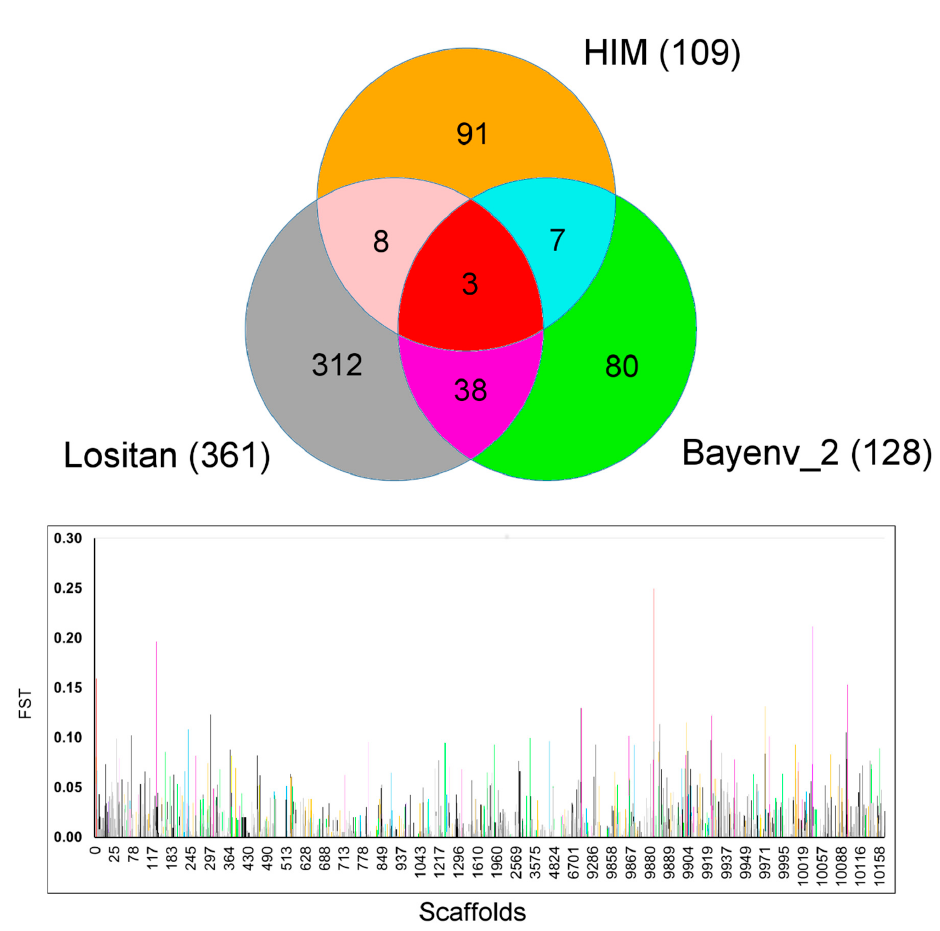
Figure 3. Venn diagram of the outlier loci interpolation among four candidate outlier detection tests and F ST value distribution of each outlier locus along the scaffolds position. In the Venn diagram (above), the numbers encased represent the number of shared SNPs between and among the corresponding set of methodologies. The colors in the Venn diagram reflect the pattern of color used in the Manhattan plot (below) that represents the scaffold position of each outlier locus and its estimated F ST value.